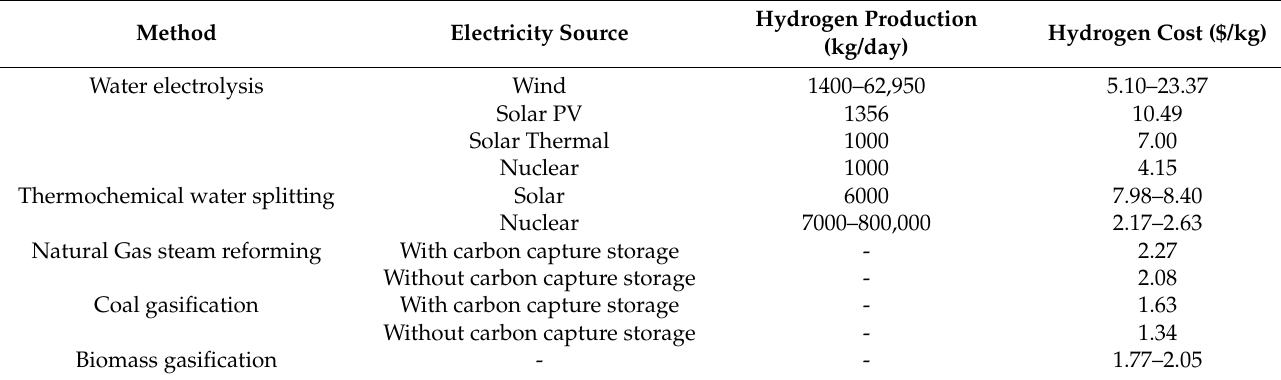
Table 2. Cost comparison of hydrogen production via various feedstock [39–43].